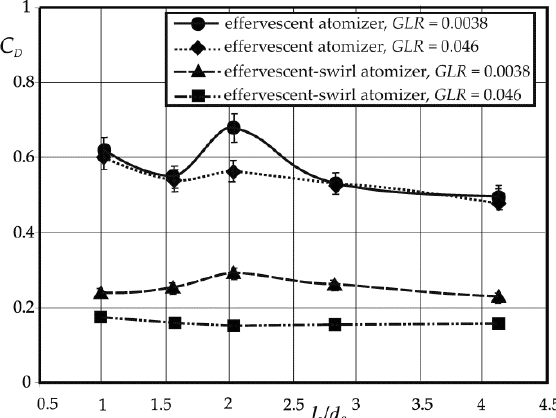
Figure 10. Graph of the dependence of the discharge coefficient on the value of l 0 / d 0 using efferves- cent and effervescent-swirl atomizers [7].